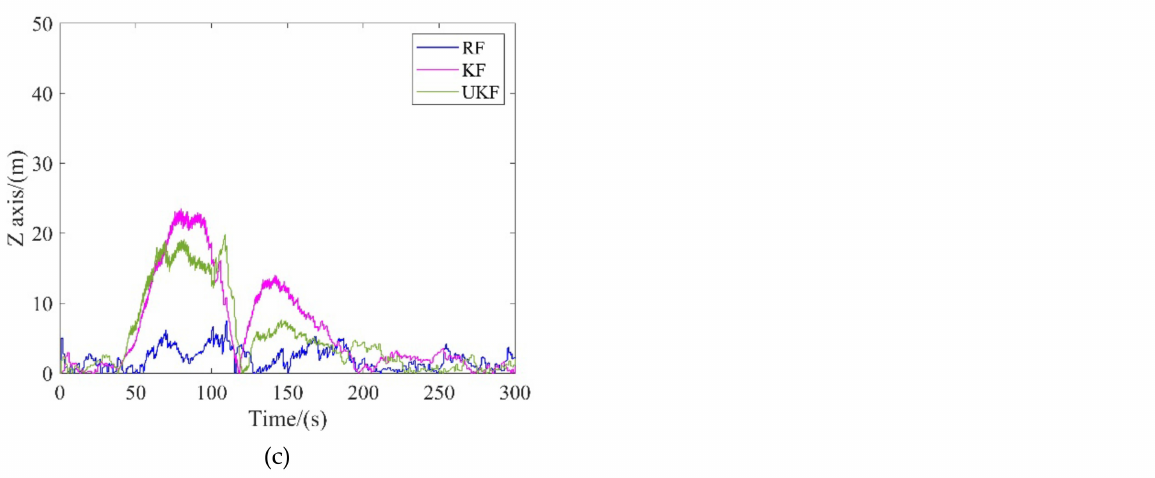
Figure 7. ( a ) X -axis position error contrast curves; ( b ) Y -axis position error contrast curves; ( c ) Z -axis position error contrast curves. Position error contrast curves under the launch inertial coordinate system.